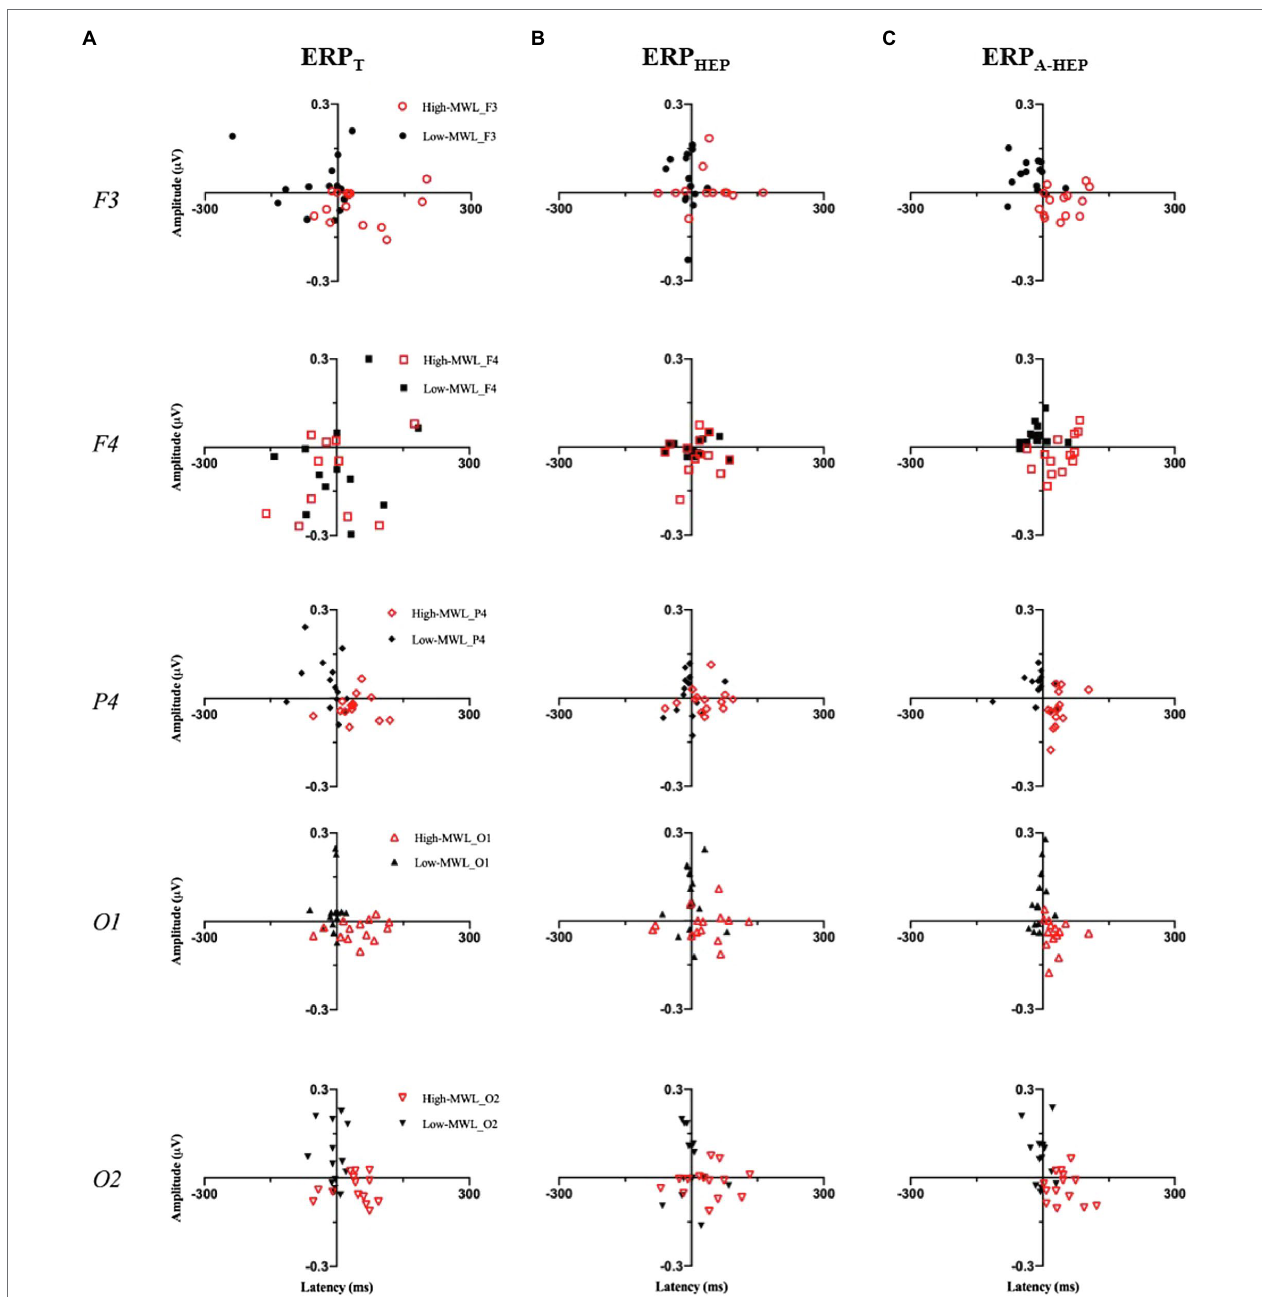
FIGURE 8 | Scatterplots of P600 amplitude (X axis) and latency (Y axis) between low- and high-MWL for the ERP T , ERP HEP , and ERP A-HEP